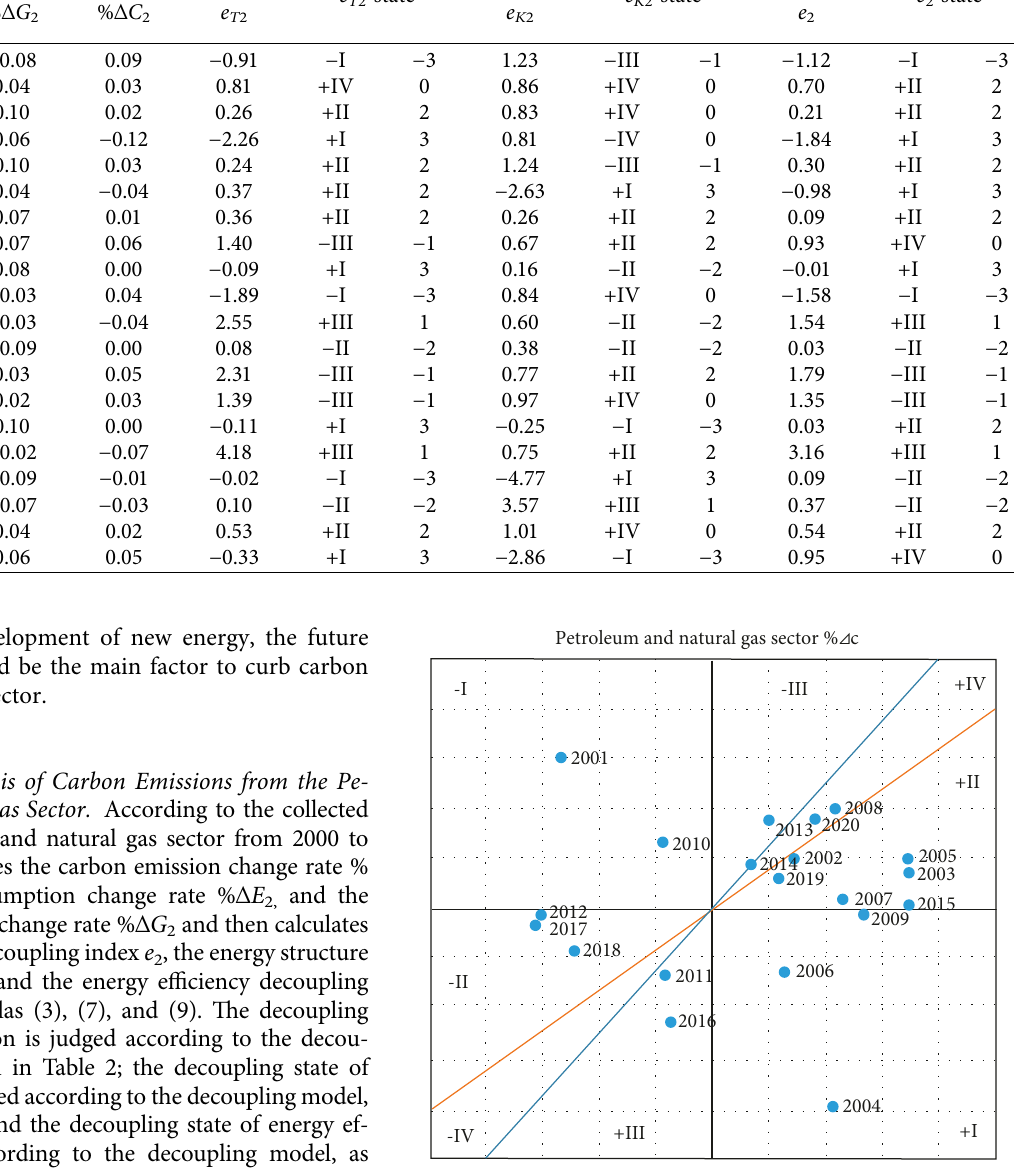
Figure 11: Carbon emission decoupling states of energy con- sumption in the petroleum and natural gas sector from 2001